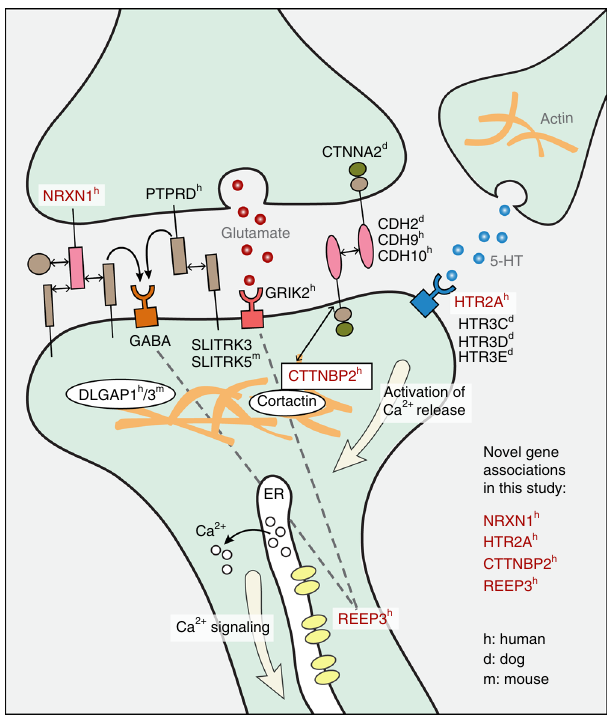
Fig. 5 All four top candidate genes function at the synapse and interact with proteins implicated in OCD by previous studies in the three species. Human, dog, and mouse are marked with superscripts h , d , and m , respectively. Genes identi fi ed in this study are shown in red . Solid lines indicate direct interactions, and dashed lines indicate indirect